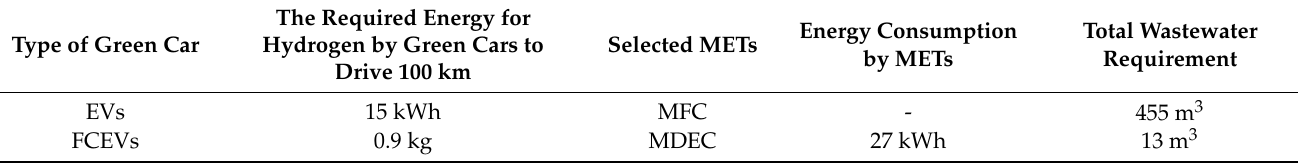
Table 3. The application of METs outputs as fuel for green